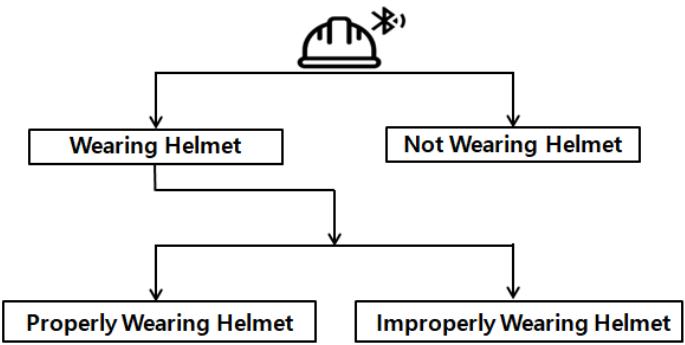
Figure 11. Safety helmet state classification chart.